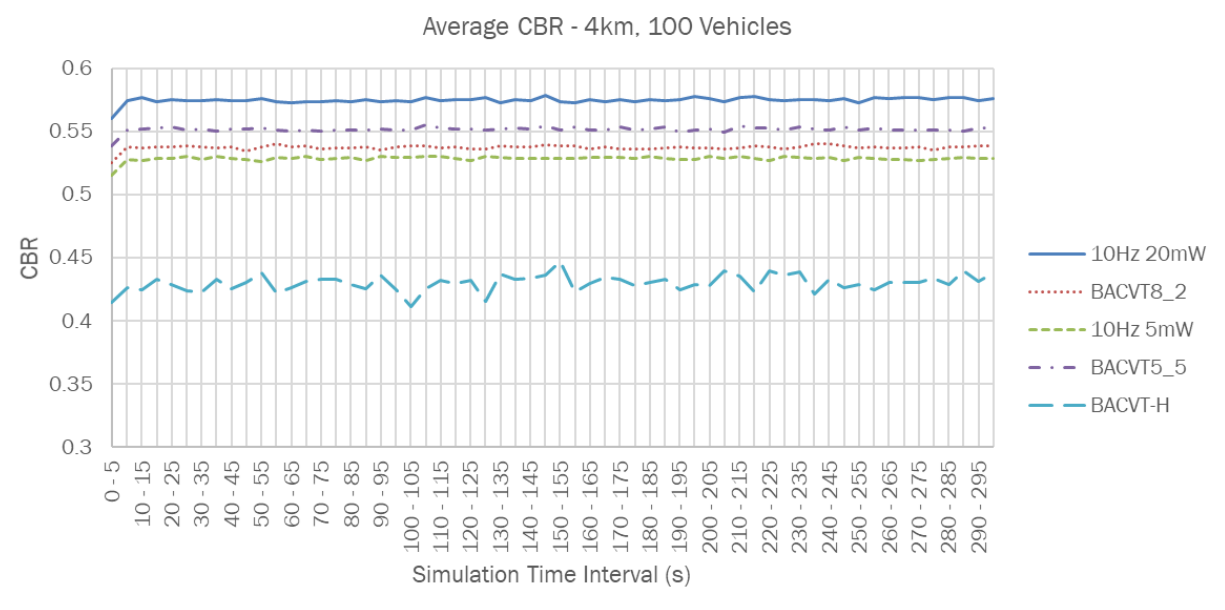
Figure 3. Average CBR in low vehicle